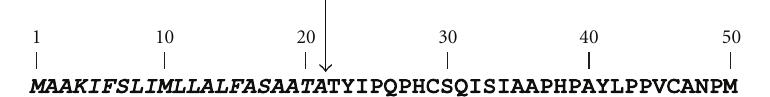
Figure 2: Predicted α -kafirin signal peptide and cleavage site are indicated in italics and arrow, respectively.